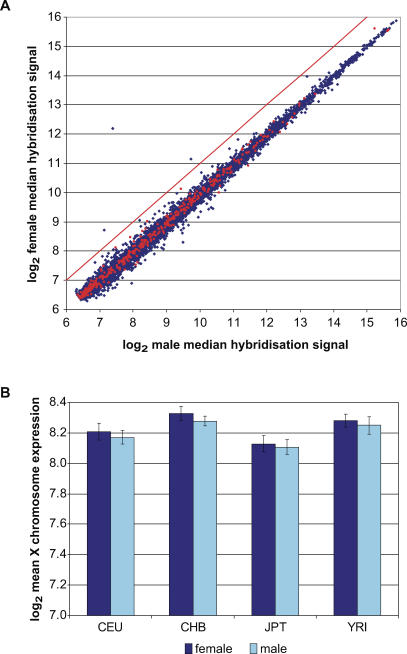
Limited Contribution of the Xi to Female Gene Expression(A) Median expression of 11,952 autosome genes (blue) and 371 X genes (red) for 30 YRI males plotted against median expression for 30 females. The red diagonal indicates the expected position of X-linked genes if expression were proportional to copy number.(B) Expression data from 371 X chromosome genes in 105 males and 105 females were normalised to the median of 11,952 autosomal sequences. The mean expression value for males and females in each population is illustrated. Error bars represent +/− 1 standard deviation.